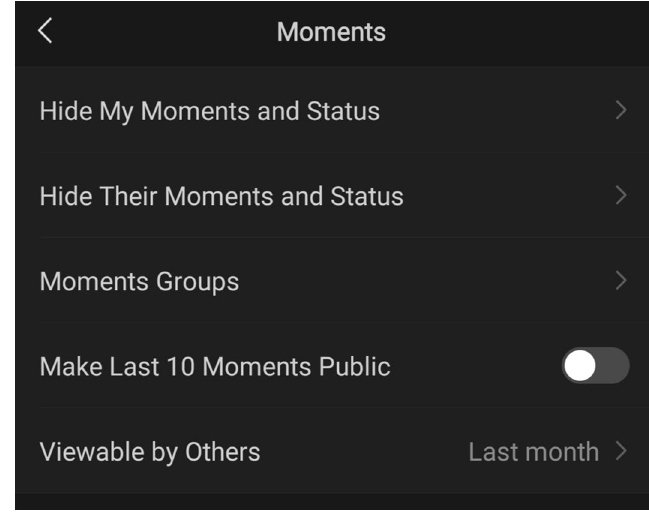
Fig. 18 Option to only showcase moments to a selected group of